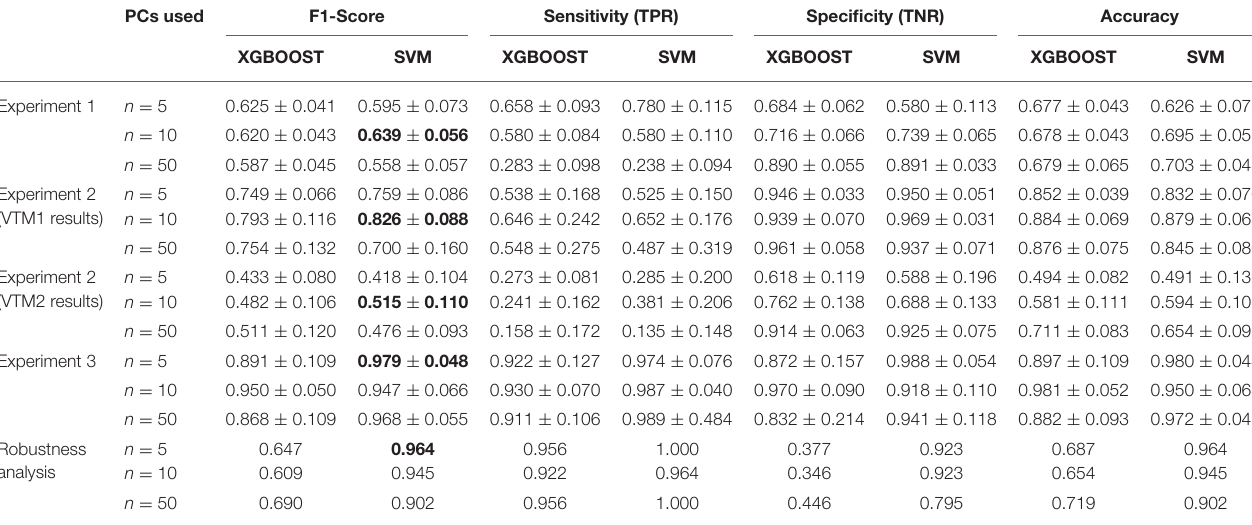
TABLE 1 | Model learning (cross validation results K = 10) of all the models tested in the different